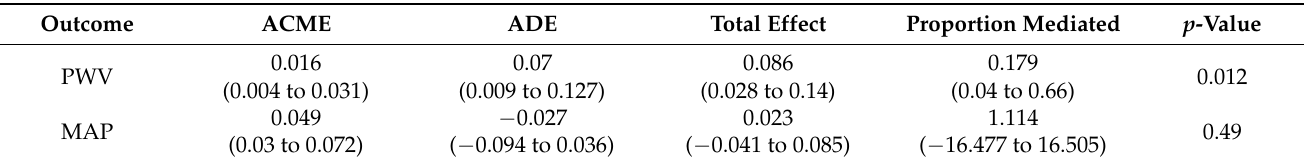
Table 3. Mediation analyses of insulin resistance on the association between HbA1c and vascular health parameters (PWV and MAP).